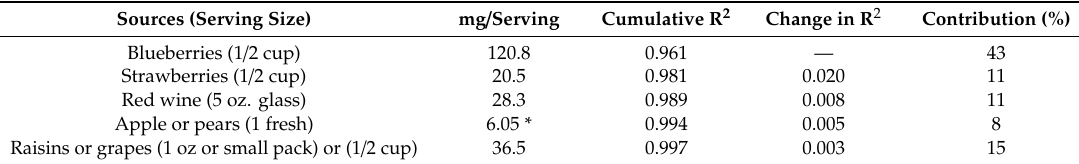
Table 2. Top contributors of total anthocyanin intake; source content, between-person variability, and contribution to total anthocyanin intake according to the FFQ items in Feeding America’s Bravest trial